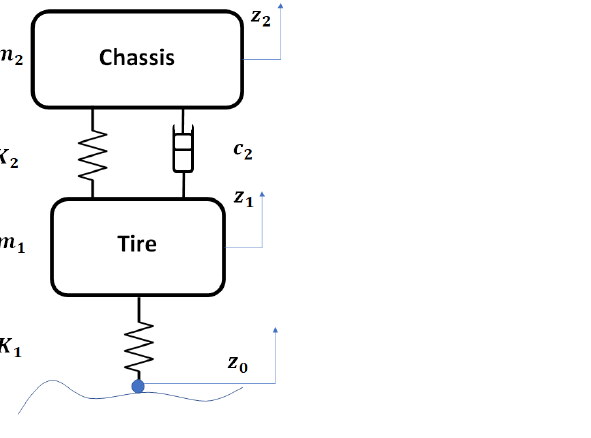
Figure 1. Quarter car model with Energy Harvester Shock Absorber (EHSA)